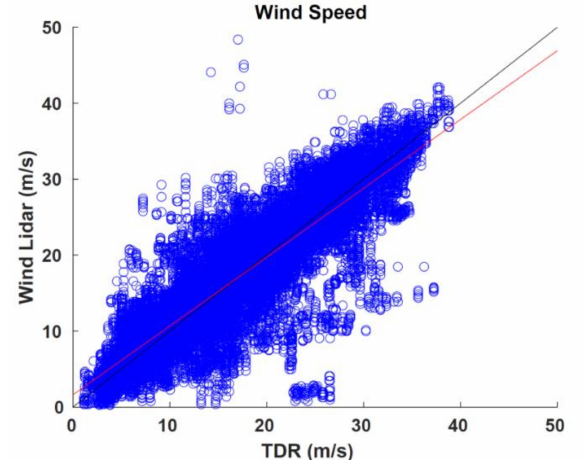
Figure 7. Comparison of collocated ADWL and tail Doppler wind radar (TDR) wind speed observations (m s − 1 ). Also shown are the line of best fit (red) and the line of perfect correlation